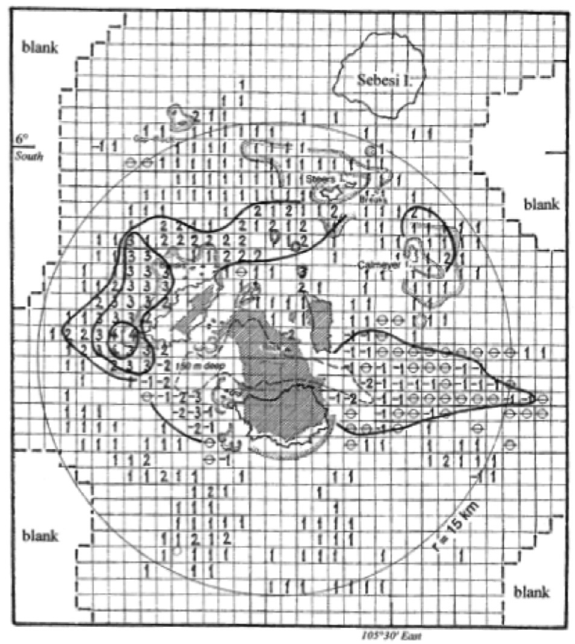
Figure 4. Distribution of thickness of volcanic ejecta, newly de- duced from Figures 3a and 3b. Dotted lines show sandbanks and lines of breakers. The broken line in the central part contours an isobath of 150 m after the 1883 eruption. A circle of 15 km radius corresponds to that of Verbeek’s figure (Figure 2a). A mesh is 1 km × 1 km. ○ —: < 0 (thin deposits); No numerals: 0~5 m (deposits of a few meter thick); 1 : 6~15 m, roughly around 10 m thick; 2 : 16~25 m, roughly around 20 m thick 20 m; 3 : 26~35 m, roughly around 30 m thick; 4 : > 35